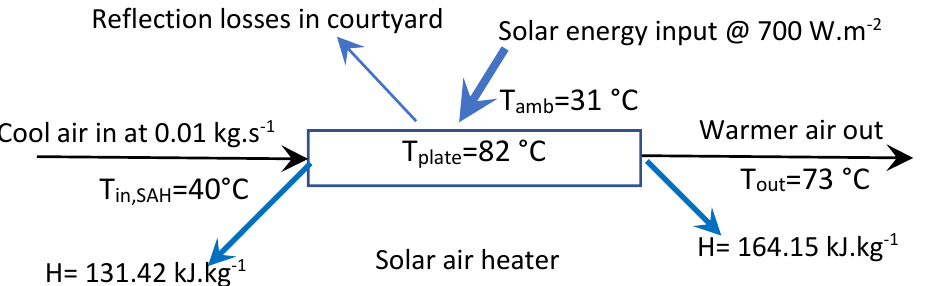
Figure 11. Schematic diagram of mass and energy flows in the experiments for performance evaluation and the heat loss measurements in the courtyard at mass flow rate of 0.01 kg·s −1 .